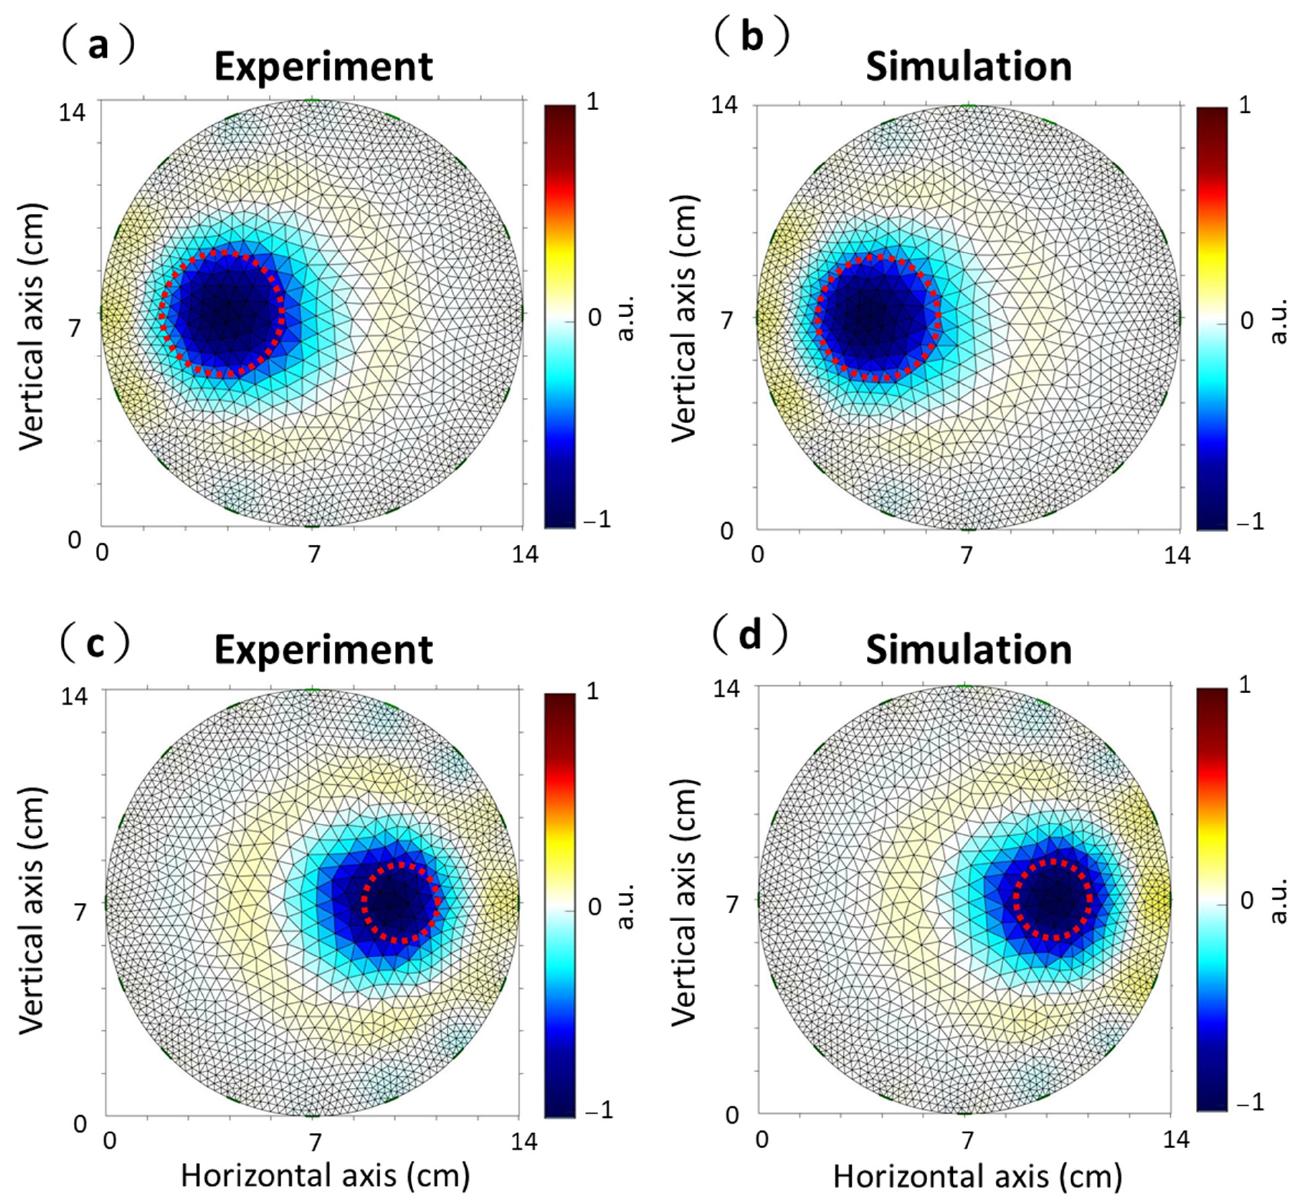
Figure 7. Experimental and simulated electrical impedance tomography (EIT) images. ( a ) An acrylic rod with a diameter of 4 cm in the acrylic cylinder. ( b ) A conductivity contrasting inclusion with a diameter of 4 cm using a 2D finite element model. ( c ) An acrylic rod with a diameter of 2.5 cm in the acrylic cylinder. ( d ) A conductivity contrasting inclusion with a diameter of 2.5 cm using a 2D finite element model. Table 1. Shape deformation (SD), position error (PE), and PE-to-radius ratio (PER) of the EIT images obtained with experiment and simulation, as shown in Figure 7.